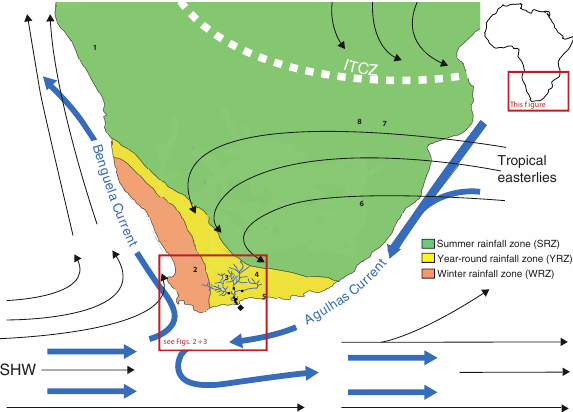
Figure 1. Schematic overview of the main components of the oceanic (thick arrows) and atmospheric (thin arrows) circulation over southern Africa (modified from Truc et al., 2013). The winter rainfall zone is colored in red, the summer rainfall zone in green and the year-round rainfall zone in yellow. Squares indicate localities of Gouritz River samples; diamond indicates marine sediment core location. SHW: southern hemispheric westerlies; ITCZ: Intertropi- cal Convergence Zone. Note that these are shown in their summer position. Austerlitz midden (1), Katbakkies Pass midden (2), Sewe- weekspoort midden (3), Pinnacle Point (4), Cango Cave (5), Nelson Bay Cave (6), Braamhoek peat (7), Lake Eteza (8), Cold Air Cave (9) and Wonderkrater